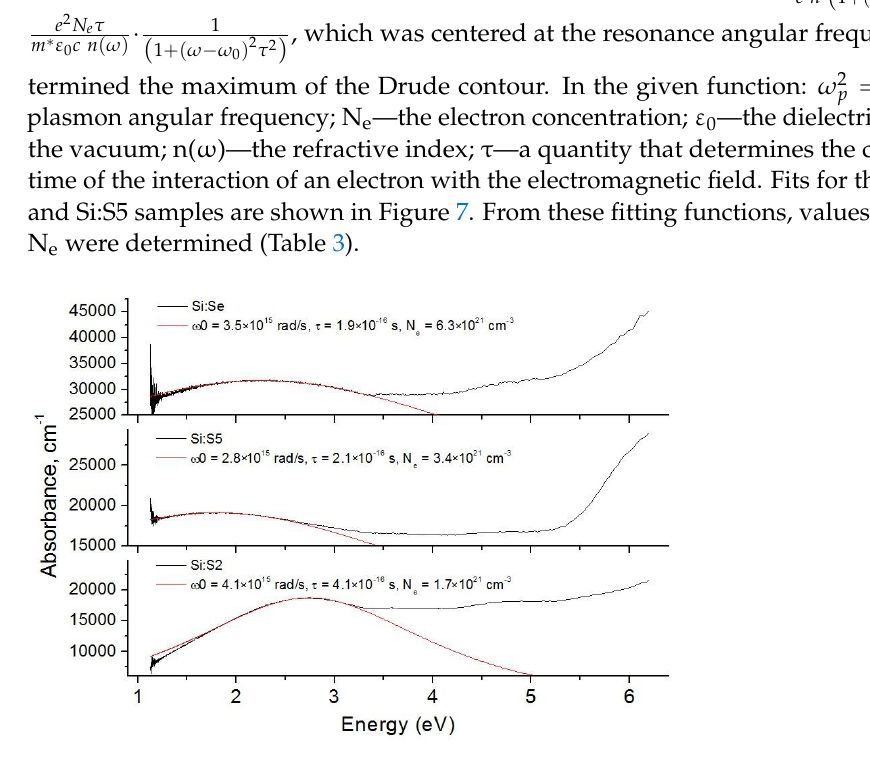
Figure 7. Approximation of absorption spectra and parameters of Drude’s absorption function. Table 3. Parameters of Drude’s absorption